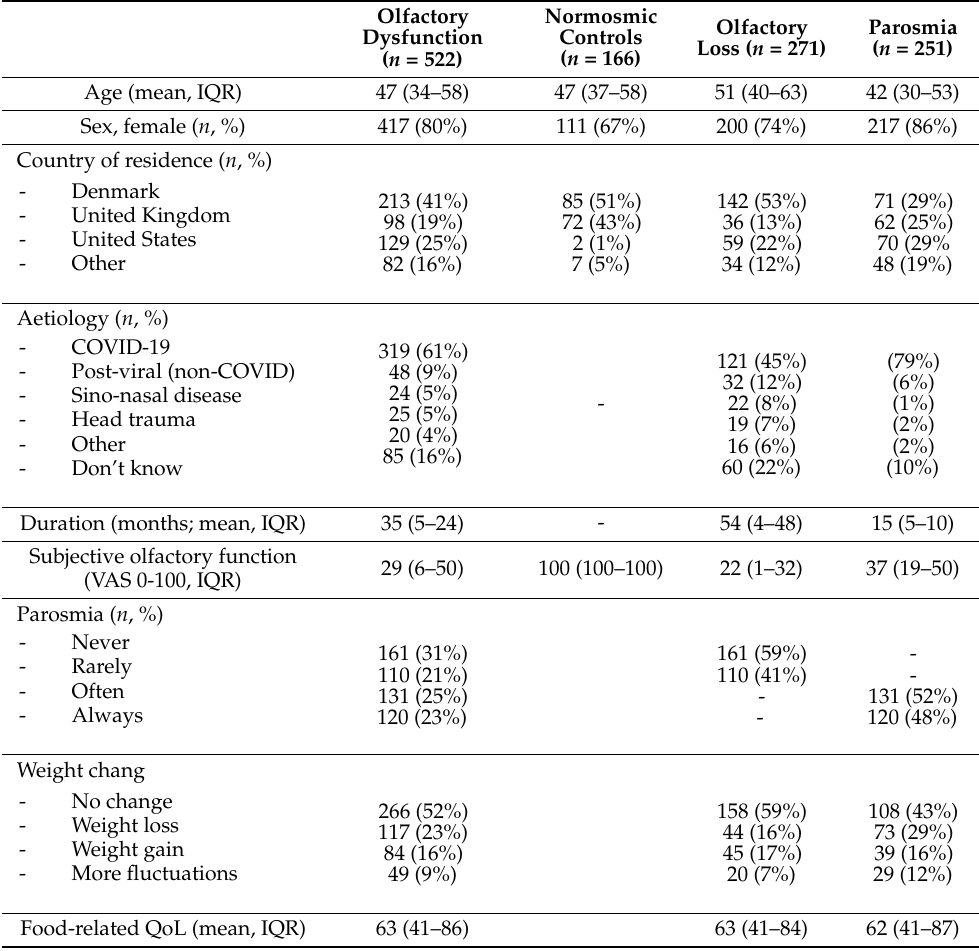
Table 1. Demographics and olfactory disorders. Inter quartile ranges were added to give an overview of the distribution of data, which reflects that the duration of smell loss did not follow parametric distribution as some patients had suffered from olfactory deficits for several years. IQR: Inter-quartile range; QoL: Quality of